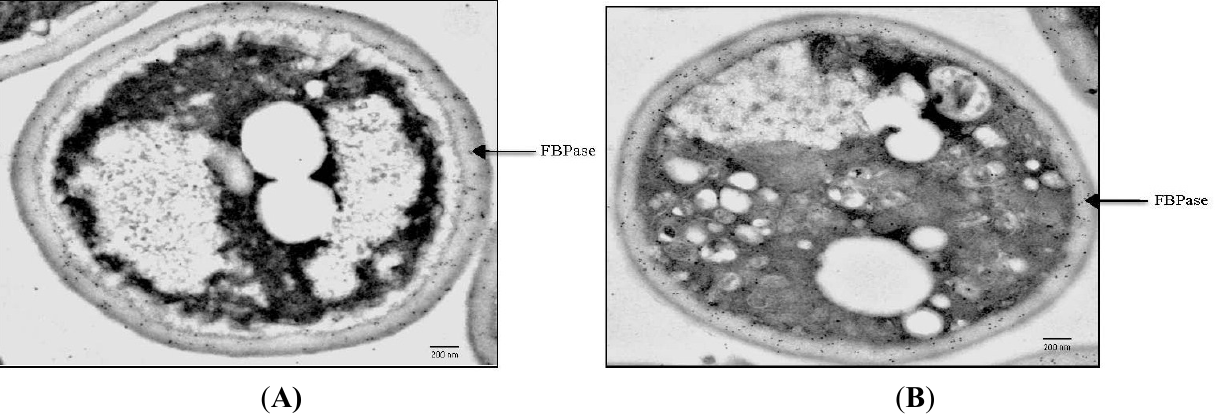
Figure 5. FBPase fails to be internalized in response to glucose in cells lacking the VPS34 gene. The ∆ vps34 mutant was starved of glucose for 3 days ( A ) and then re-fed with